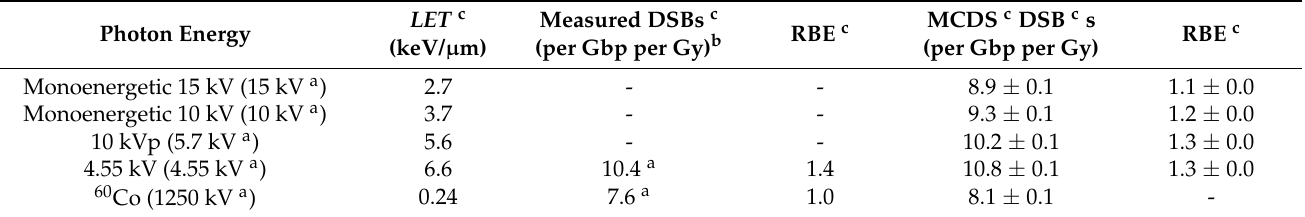
Table 3. Absolute yield of DSBs (per Gy per Gbp) (mean ± standard error) induced by soft X-rays and 60 Co γ -rays at an oxygen concentration of